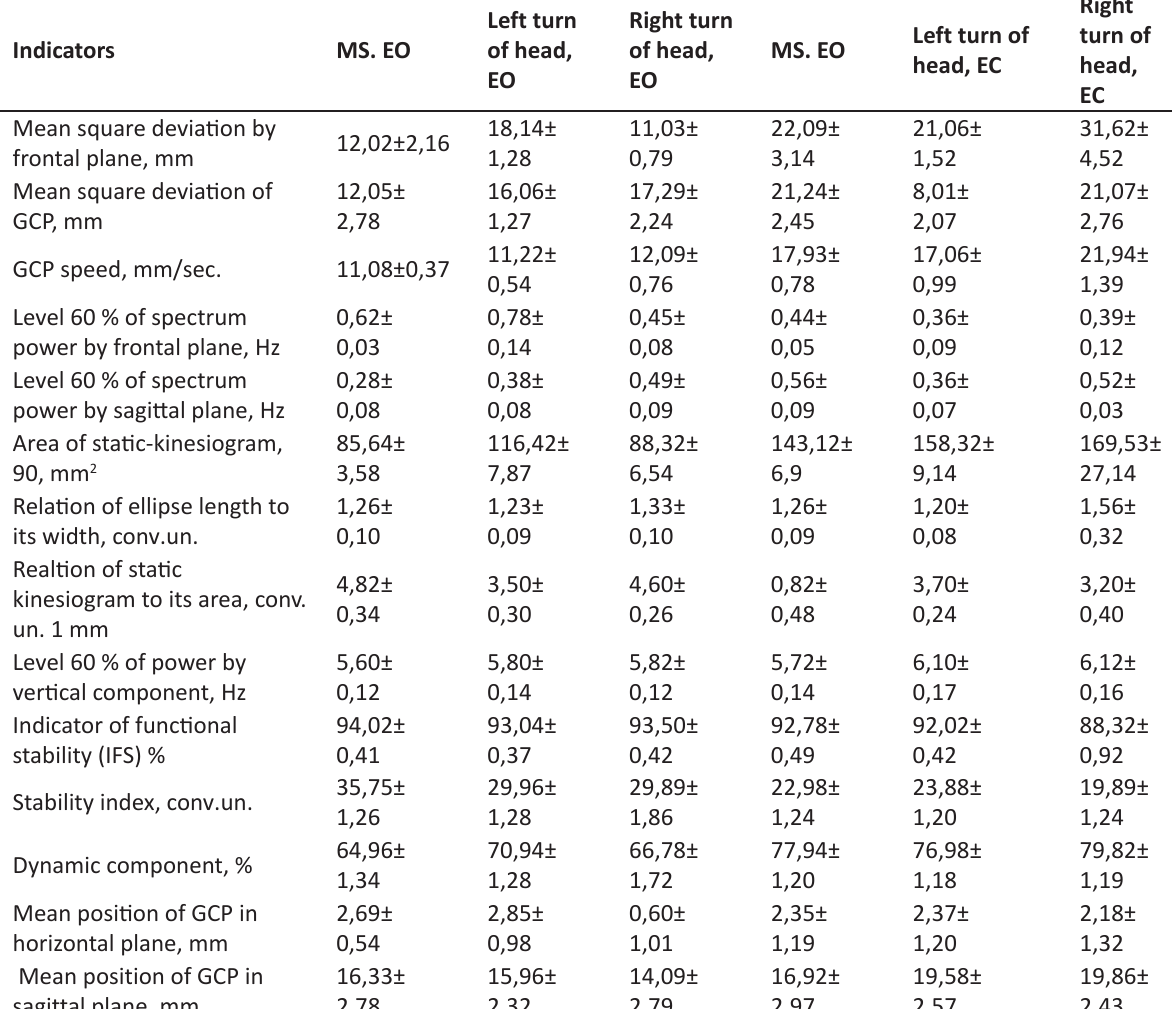
Table 3. Stabilometric indicators of athletes-orienteers (boys; n=17, M±m)